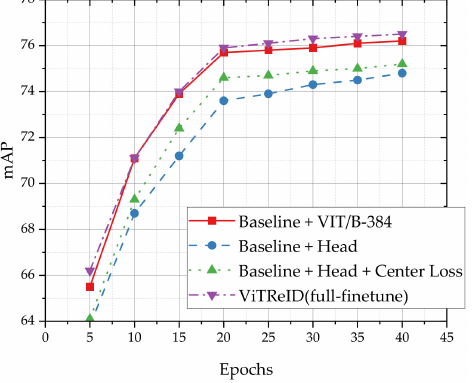
Figure 4. mAP change of MSMT7 →